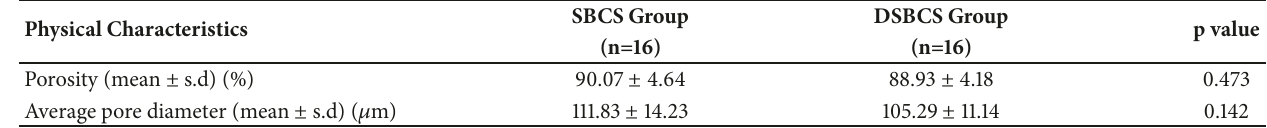
Table 2: Average pore diameter and porosity in SBCS group and DSBCS group.